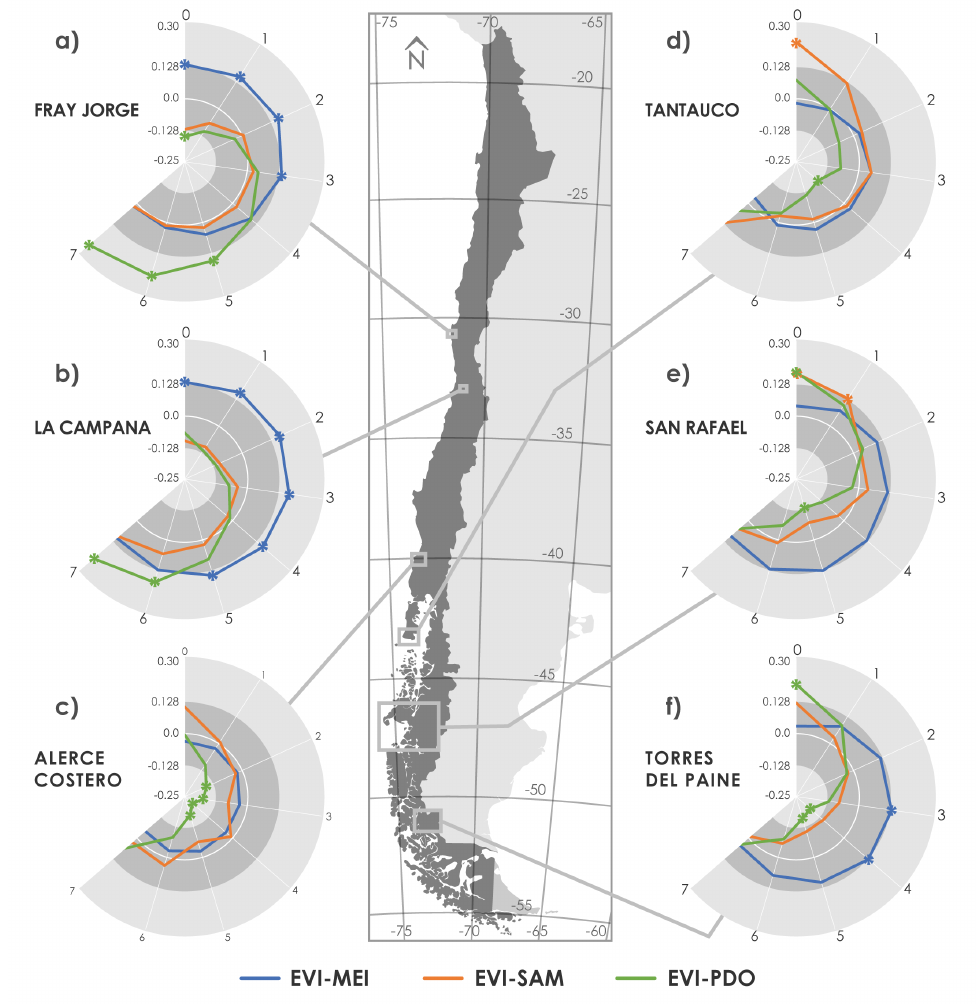
Figure 7. Lagged correlations between EVI and MEI (blue line), EVI and SAM (orange line) and EVI and PDO (green line) in each park (see order in Figure 1). The external numbers around the ring show the respective lag (0 to 7) between the climatic data and EVI. Points marked with asterisk and on the light gray zone of the circle are statistically significant at